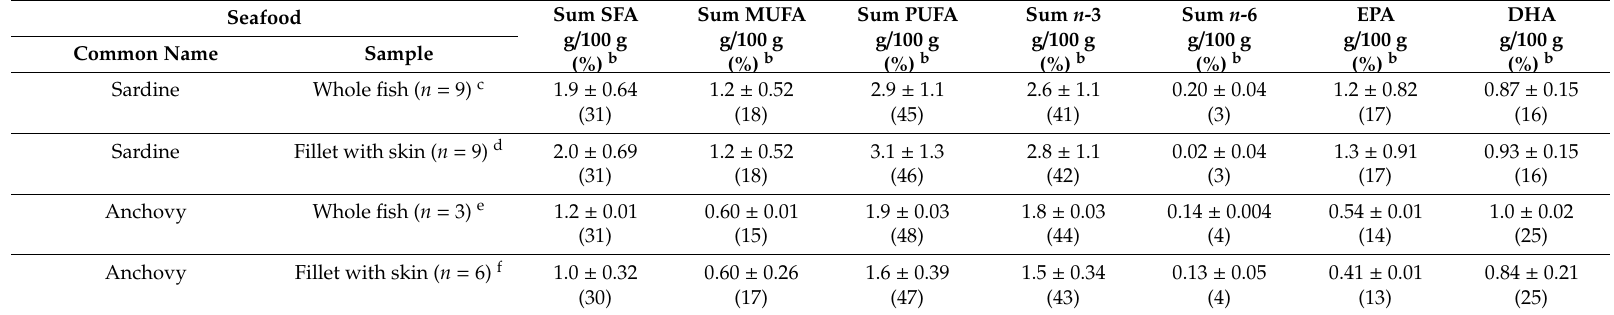
Table 4. Analytical values for total fat and fatty acids in di ff erent species of fish sampled on the EAF Dr. Fridtjof Nansen cruise from Tangier to Cap Bojador in May 2017 (mean ± SD) a